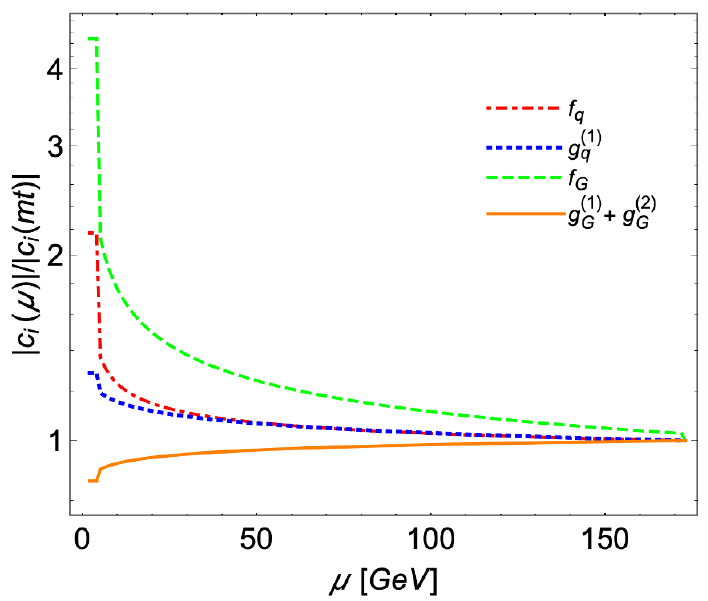
Figure 4 . Variation of the log ratio of Wilson coe(cid:14)cients c i ( (cid:22) ) =c i ( m t ), as indicated, with the 10 scale (cid:22) , for the Q L model with m (cid:31) = 10 GeV, M ~ q = 1 TeV, and g DM =